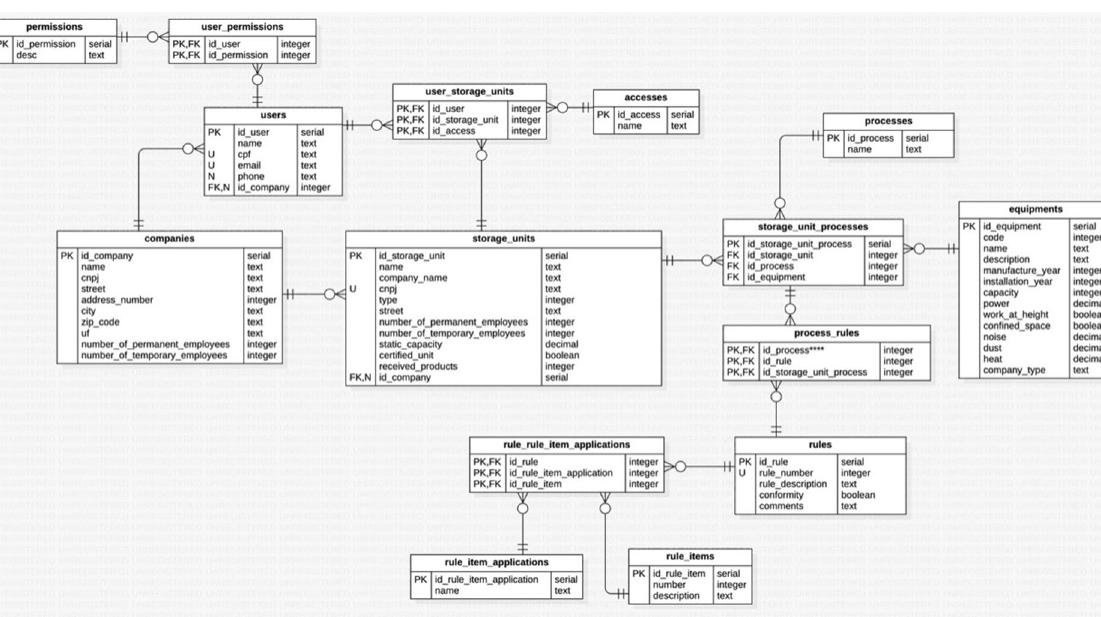
Figure 10. Algorithm detailed to manage occupational safety at grain handling and storage facilities chart